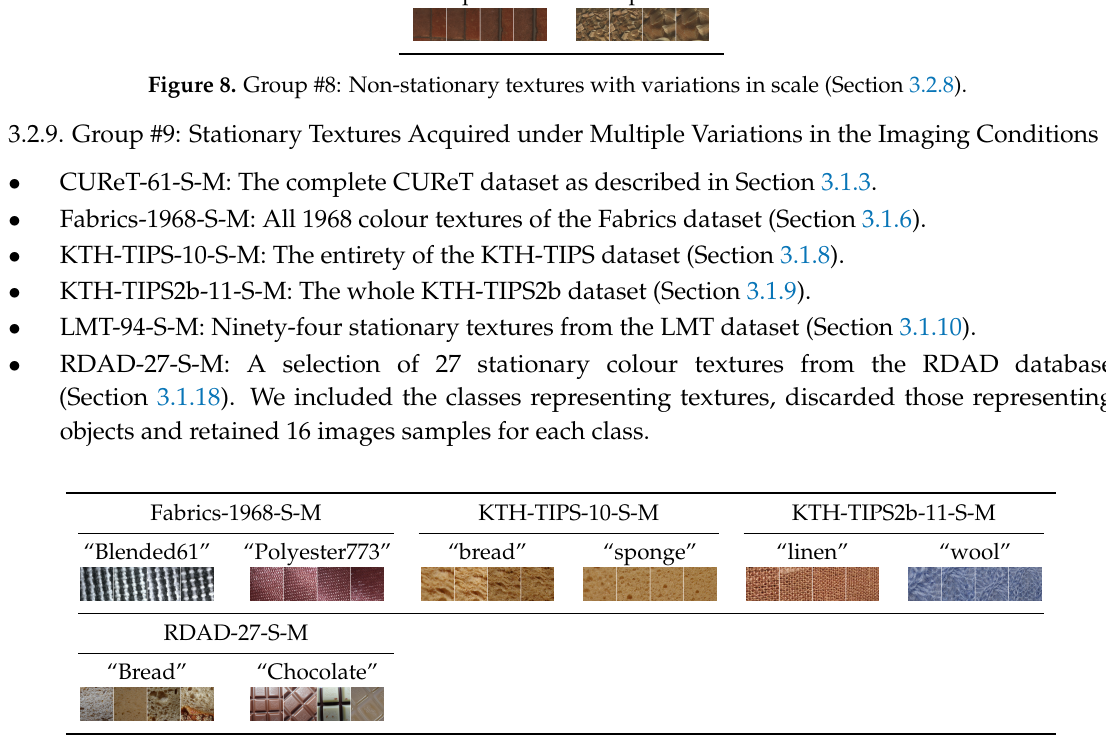
Figure 9. Group #9: Stationary textures acquired under multiple variations in the imaging conditions (Section